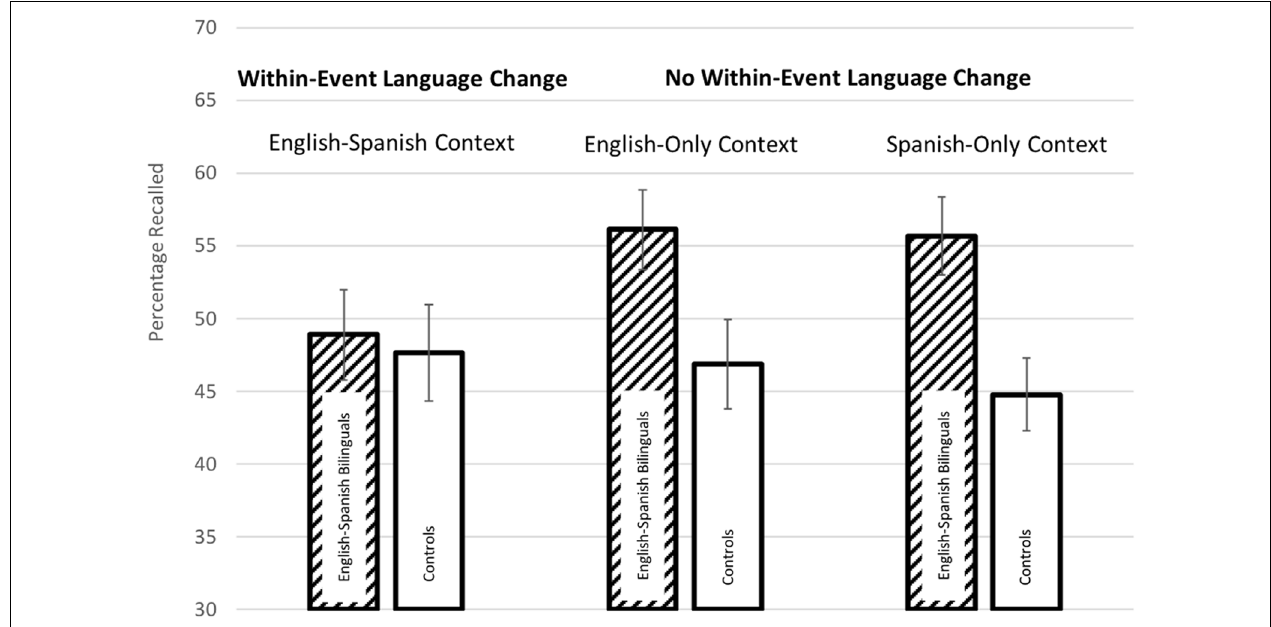
FIGURE 3 | Visual memory performance when there was (and was not) a change in language context within an event. This image displays visual memory performance (percentage of shapes recalled) for English-Spanish Bilinguals and Controls when there was a change in language context within an event (English-Spanish Context) and when there was no change in language context within an event (English-Only Context and Spanish-Only